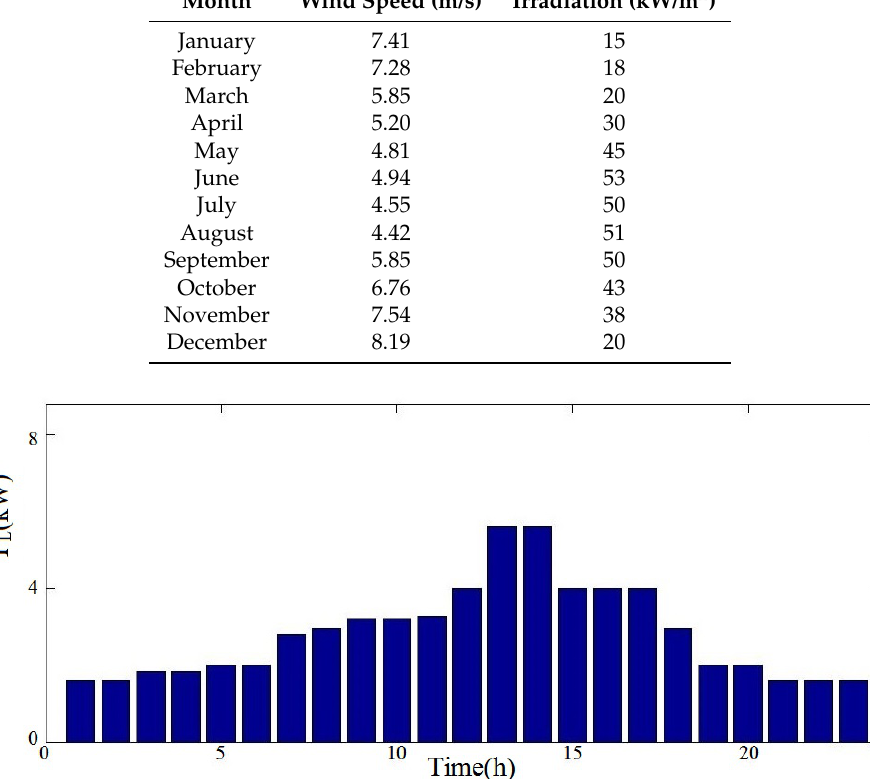
Figure 8. Daily load.